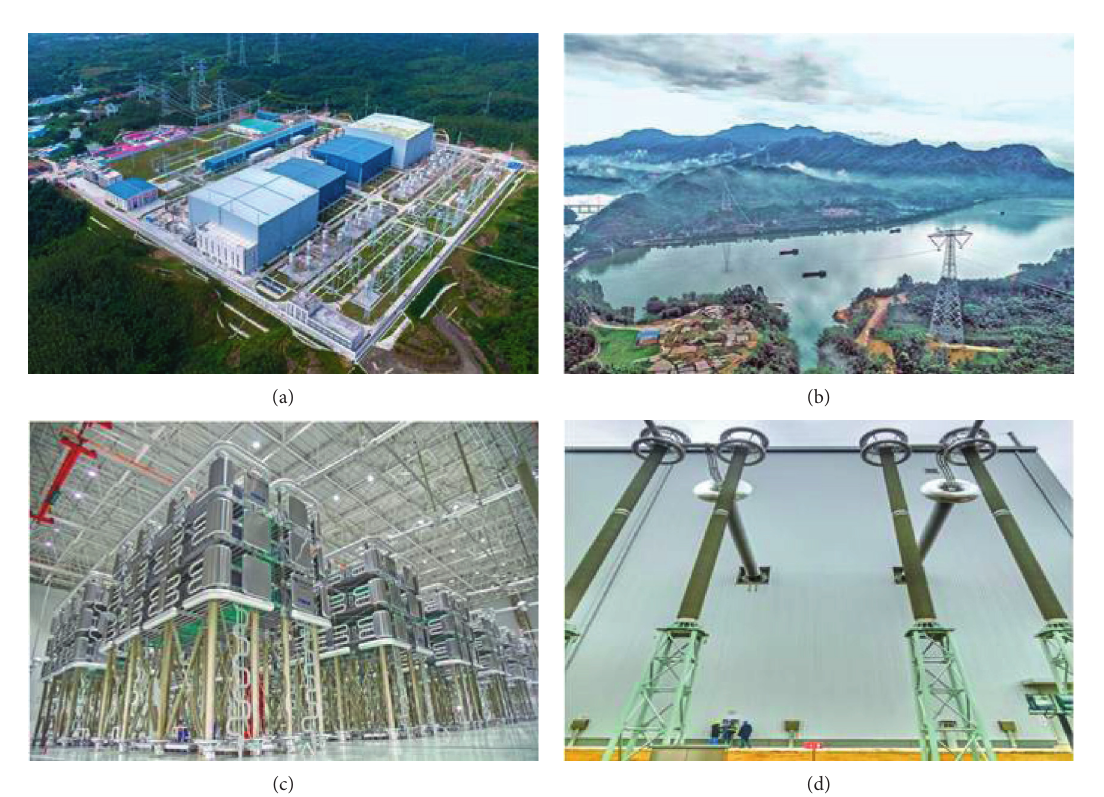
Figure 2: The Kunliulong DC Project construction site. (a) The ± 800kV converter station. (b) The Guangdong section crosses the Beijing river transmission line. (c) Construction site of VSCUHVDC converter valve. (d) Inspection site of casing through wall for VSC-HVDC.